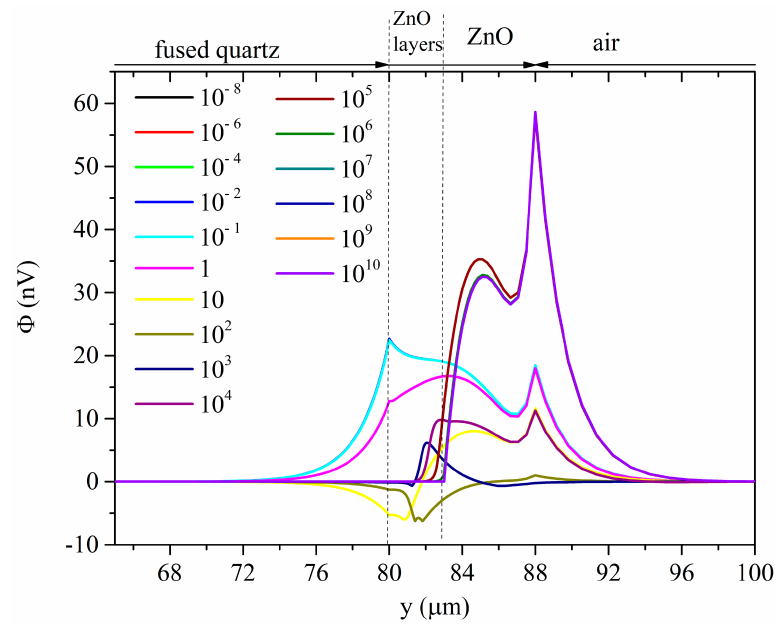
Figure 16. The electric potential distribution under the Rayleigh mode at some conductivity values, under bottom illumination, and when δ UV = 200 nm.